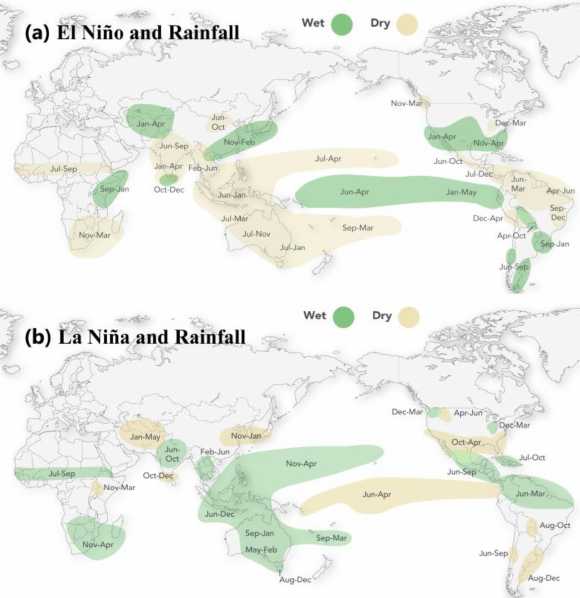
Figure 1. Typical rainfall patterns during El Niño and La Niña events based on the whole months of rainfall from 1951–2016